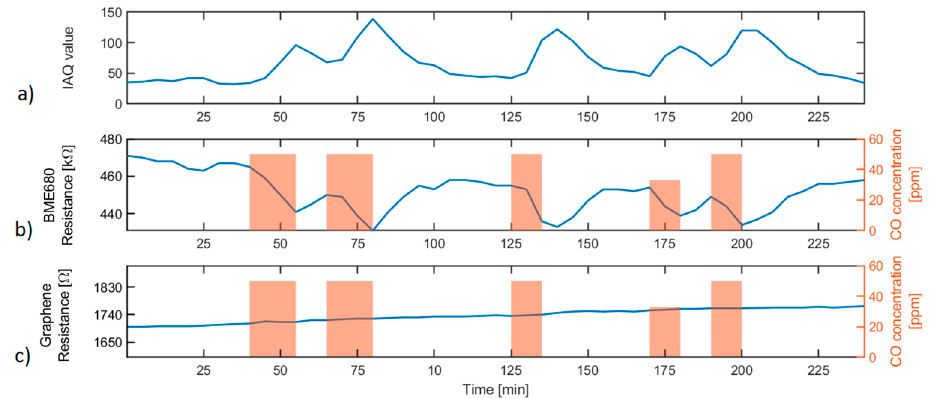
Figure 9. Sensor response to CO. ( a ) Index of air quality (IAQ) value calculated by means of the BME680 using the BSEC software library, ( b ) BME680 MOX sensor resistance, and ( c ) graphene sensor resistance. Right y-axes of graphs b and c show the CO concentration during the gas exposure. Results obtained for exposures to CO at 35 and 50 ppm during periods between 10 and 15 min show how the BME680 MOX sensor resistance and IAQ value follow the changes in gas concentration.